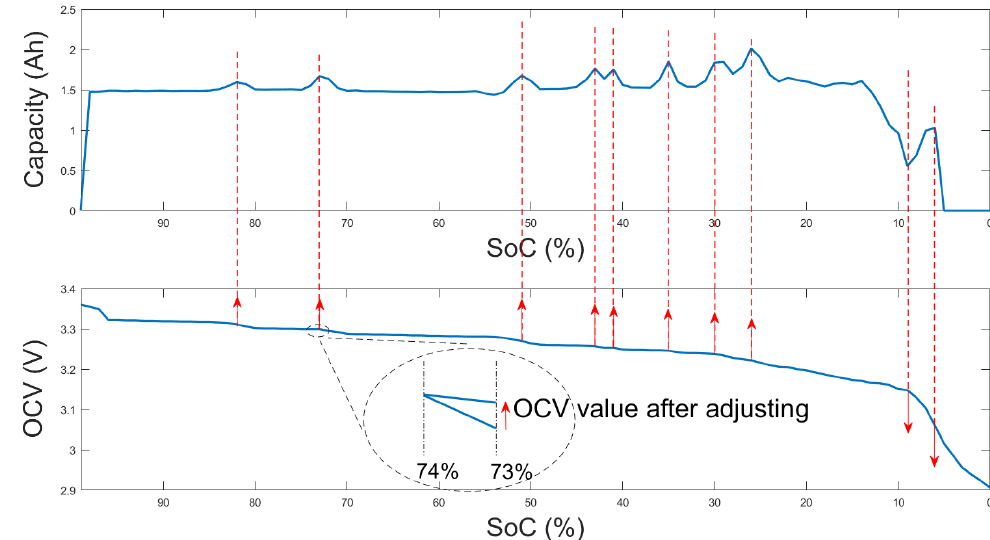
Figure 5. The OCV curve is adjusted based on the difference of